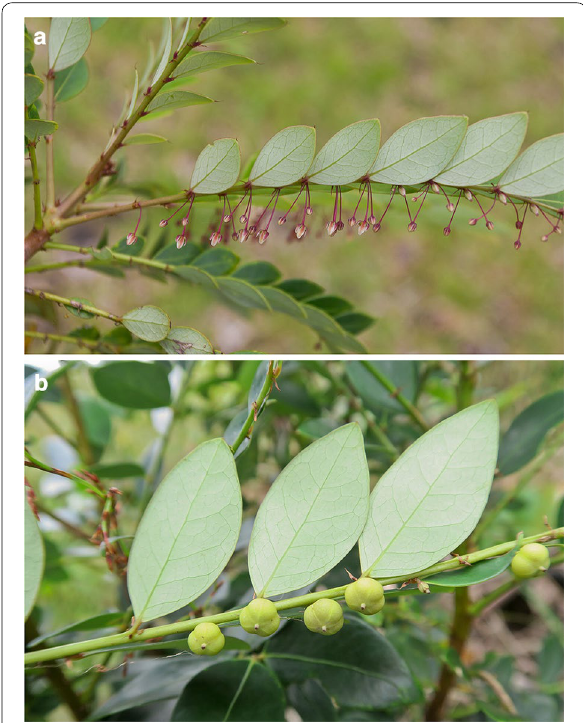
Fig. 2 Detail of P. rufuschaneyi plants. a Inflorescences of P. rufuschaneyi , note the difference between main stem and side stem with at the base small structures that signal phyllanthoid branching; b fruit capsules of P. rufuschaneyi . Images by A. van der